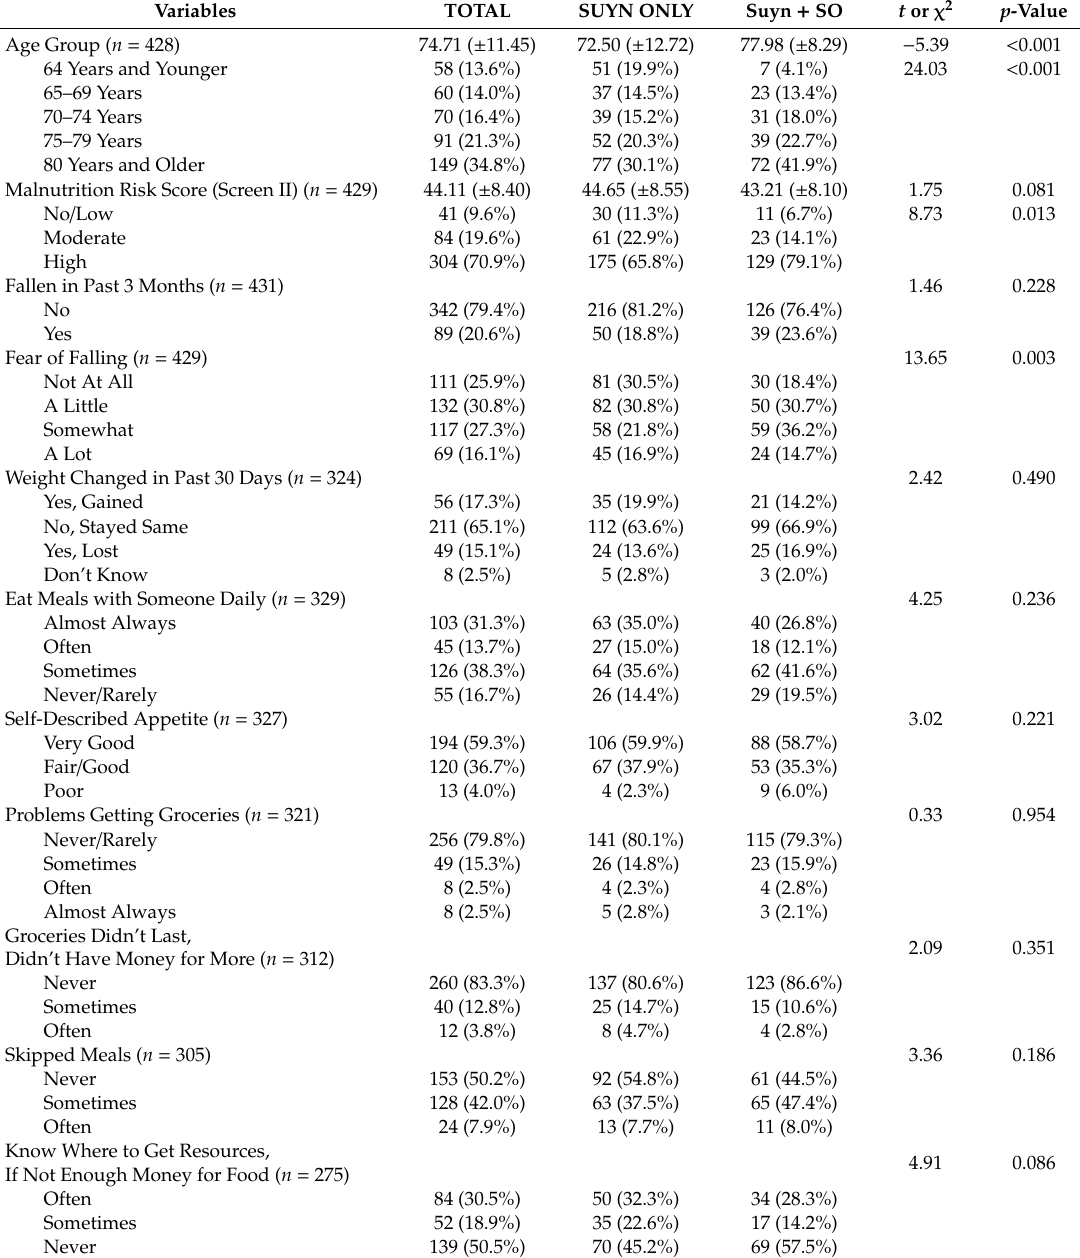
Table 4. Baseline Characteristics for SUYN Participants by Study